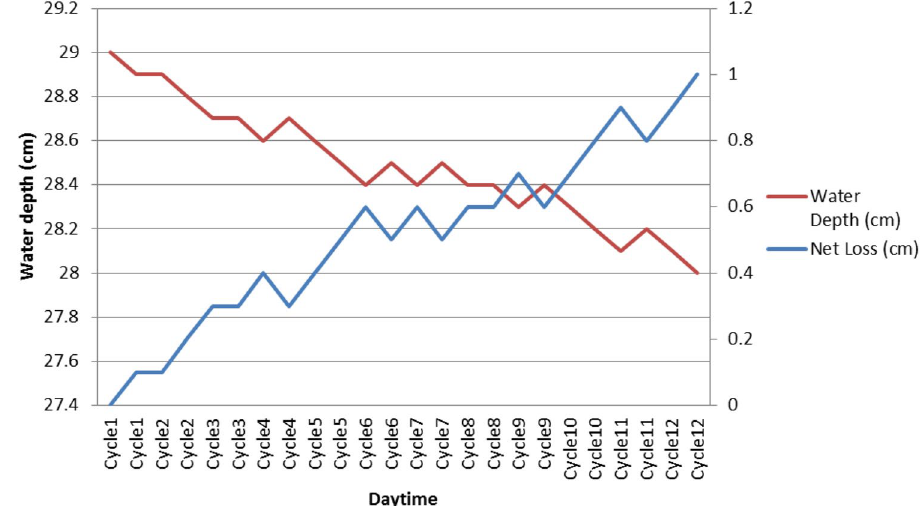
Fig. 12 water recycling process analysis. Water depth indicates the height of the water in the